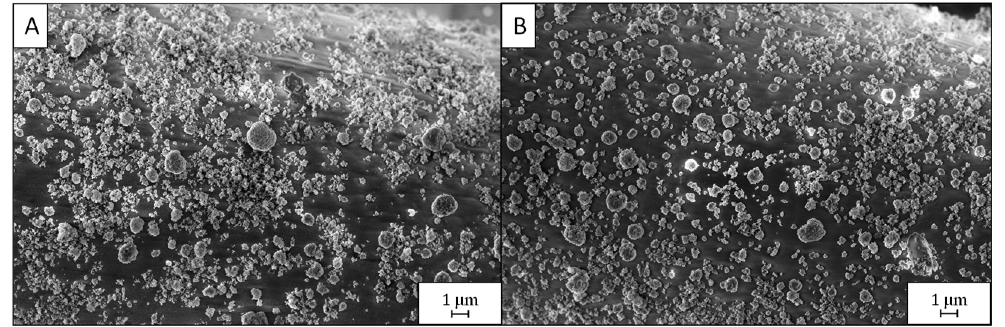
Figure 5. SEM micrographs of PD3m before ( A ) and after ( B ) the photocatalytic process (top view at 10kx magnification).